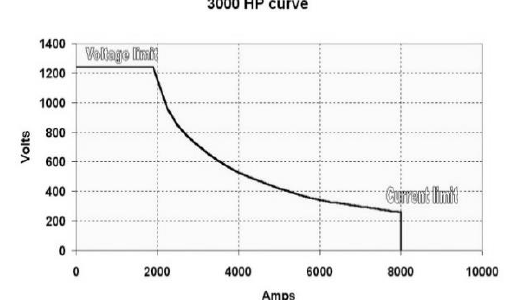
Fig. 2. Typical main generator constant power curve at “notch